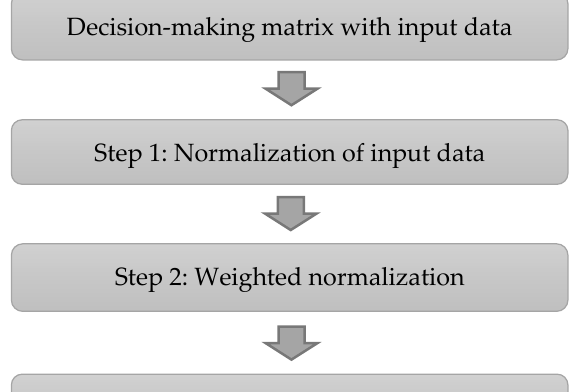
Figure 1 represents all of the abovementioned steps of extracting the rank of alterna- tives from the decision matrix.